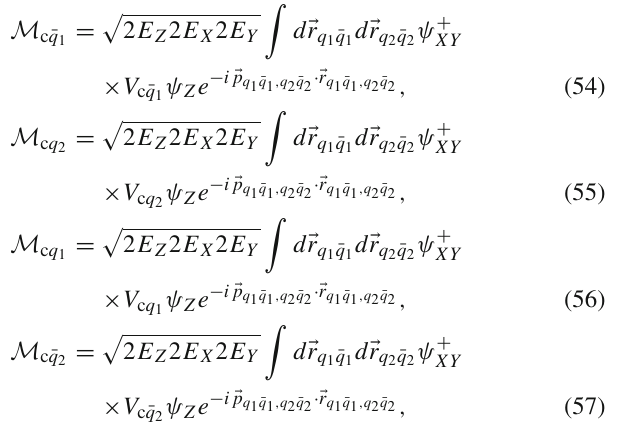
where V c ¯ q , V c q , V c q , and V c ¯ q are the transition potentials 1 2 1 2 for the processes where a gluon is emitted by a constiutent quark or antiquark in the initial mesons and subsequently the gluon creates a quark–antiquark pair, and are given in Eqs. (51) and (52) of Ref. [66]. The two upper diagrams give ( p (cid:7) ) + q ( p (cid:7) ) → q ( p ) + ¯ q ( p ¯ ) + q ( p ) + ¯ q ( p ¯ ) , ¯ q q 1 q 1 q 2 q 2 1 2 1 1 2 2 ¯ q q 2 1 ) + ¯ q ( p (cid:7) ) → q ( p ) + and the two lower diagrams q 1 ( p (cid:7) q 1 2 1 ¯ q q 1 2 The transition amplitudes squared are given